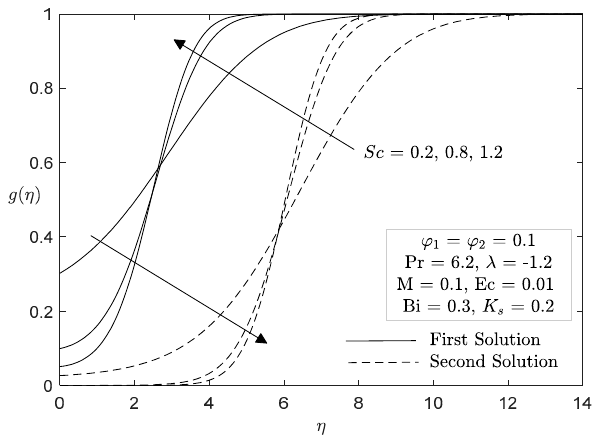
Figure 12. Concentration profile for various values of Sc .